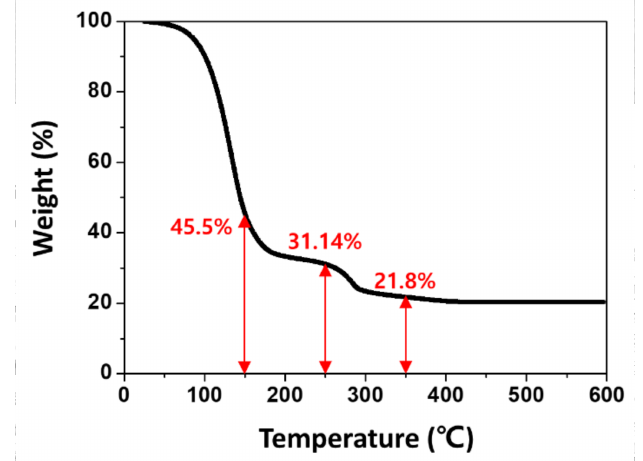
Figure 3. Thermogravimetric analysis curve of TiO 2 nanoparticle